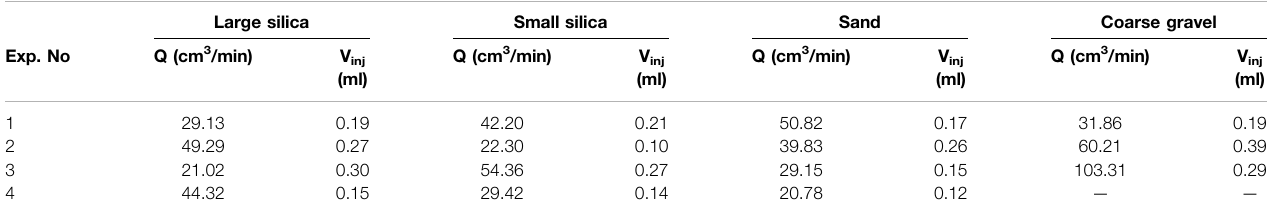
TABLE 4 | The fl ow rates (Q) and injected tracer volumes (V inj ) for the fl uorescent tracer tests. Large silica Small